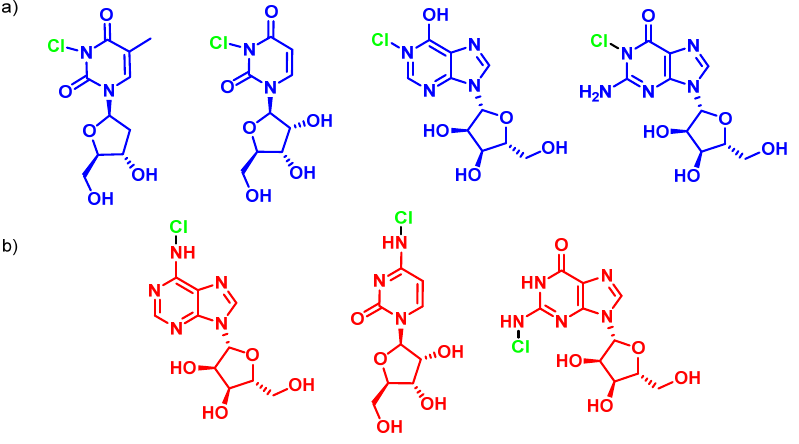
Figure 43. Reaction of AMP/ADP/ATP with HOCl and chlorination at the primary amino group of the adenosine derivative.